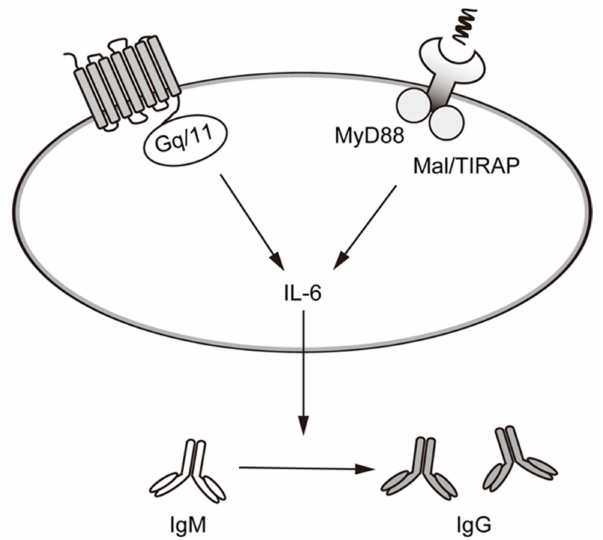
Figure 5. Activation of mAChRs and nAChRs enhances IL-6 release and immunoglobulin class switching from IgM to IgG in Daudi cells. Cooperative activation of mAChRs and TLR2 promotes the production of the IL-6 responsible for B cell maturation. In Daudi cells, this leads to class switching from IgM to IgG. Signals from nAChRs are important for activating the MyD88 and Mal/TIRAP pathways, which in turn increases the production and release of